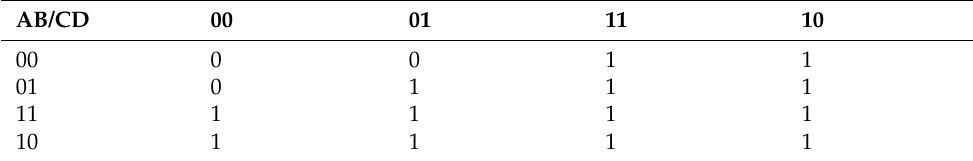
Table 7. Karnaugh map according to Table 5 for the cooling loads.